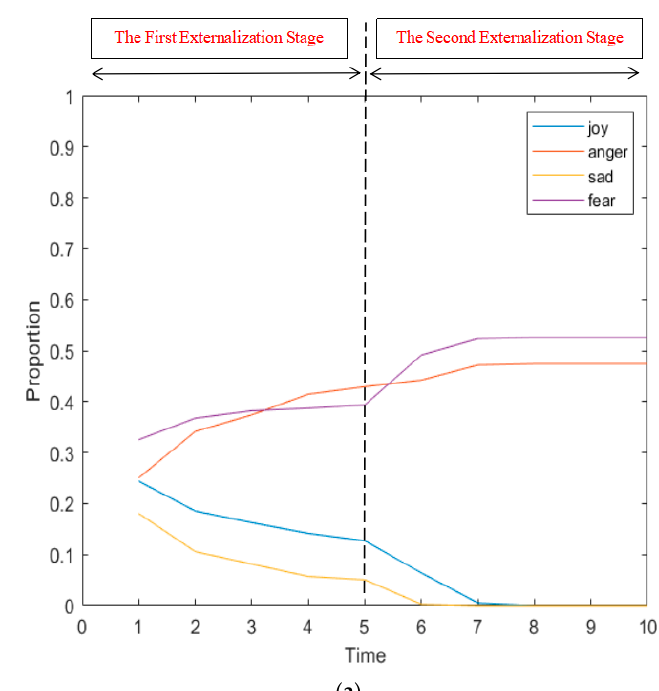
Figure 13. The changes of numbers of interactive nodes under different t 1.